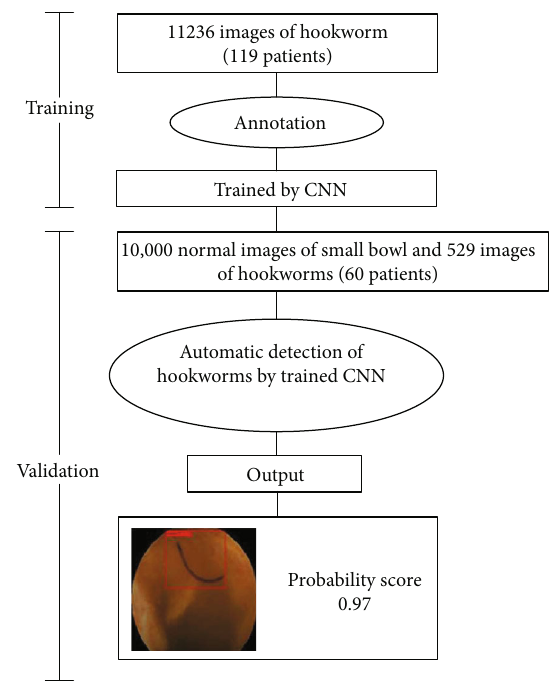
Figure 1: The fl owchart of this